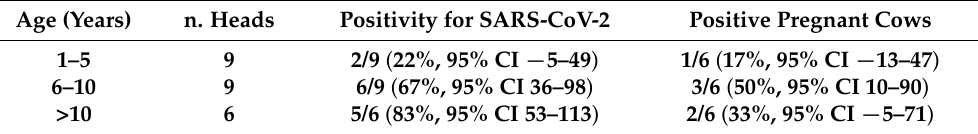
Table 2. SARS-CoV-2 positivity (MTN) among cows divided into groups by possible risk factor (age and pregnancy status).